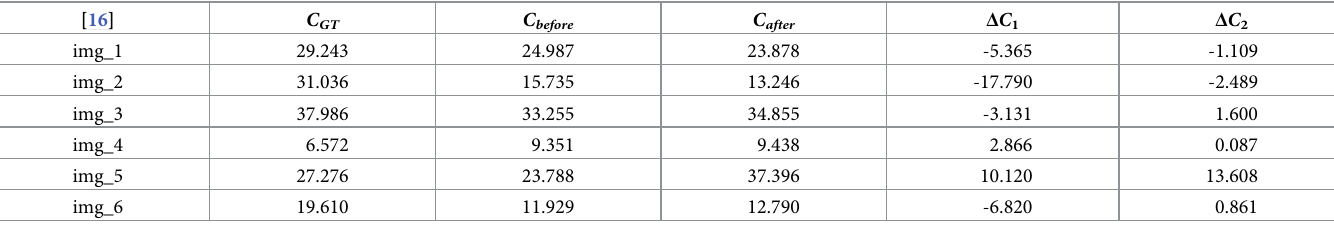
Table 3. The influence of HE on the colorfulness of Iizuka et al.